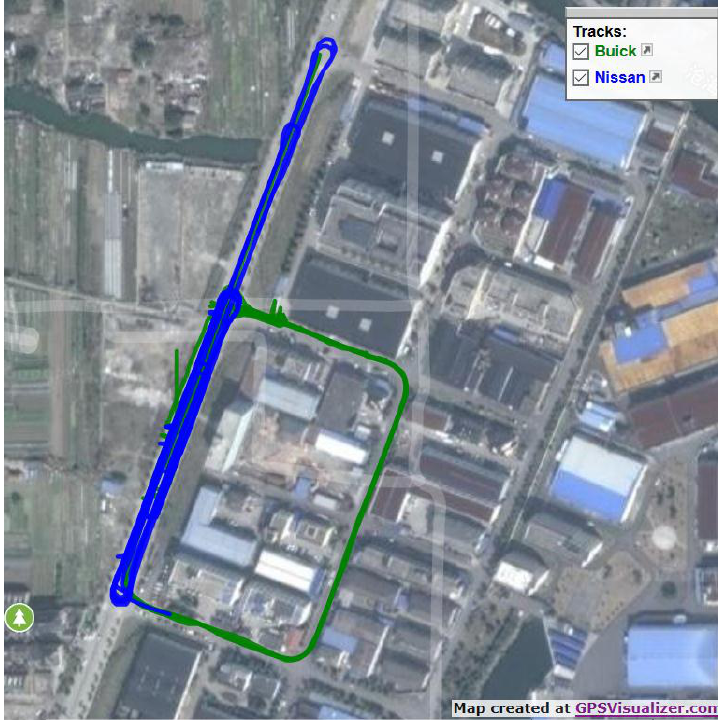
Figure 8. Test trajectories of the two vehicles.